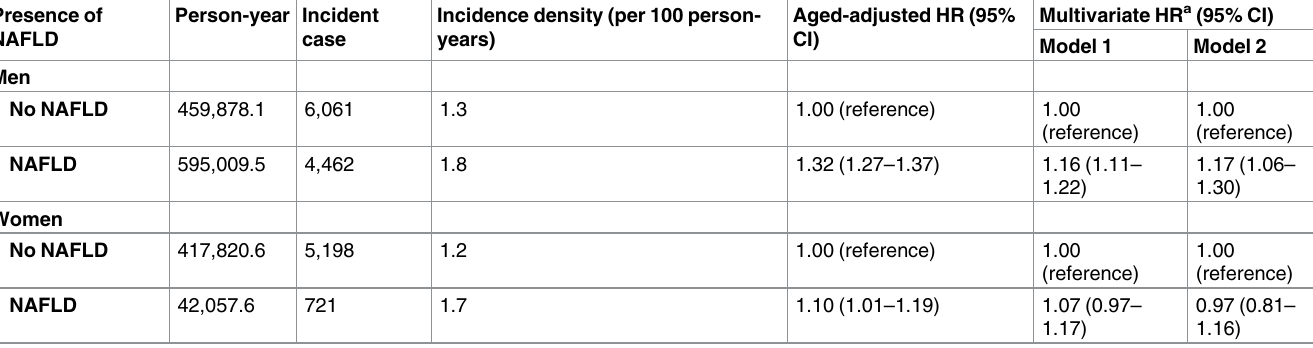
a Estimated from parametric Cox models. Multivariable model 1 was adjusted for age, center, year of screening exam, smoking status, alcohol intake,